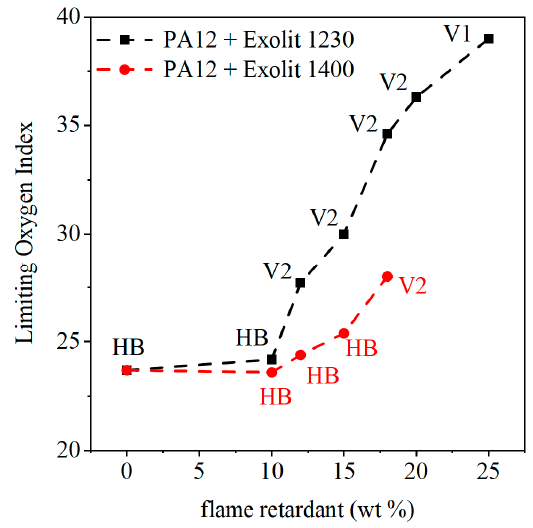
Figure 8. LOI and UL-94 results of the laser-sintered specimen for different flame retardant